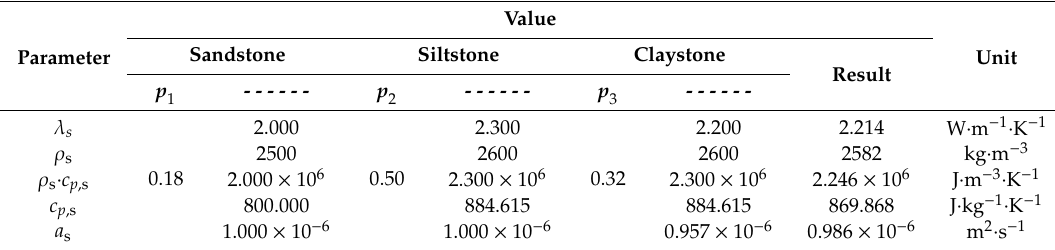
Table 2. Mathematical model—values of the chosen physical parameters in the target object Heat Source 5 based on the percentage content of particular